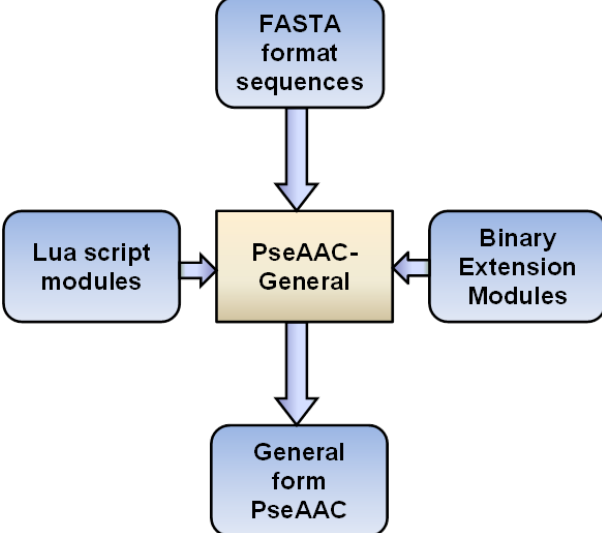
Figure 1. The data flow of pseudo-amino acid composition (PseAAC)-General. The input data is FASTA format sequences. The output data is general form PseAAC. The mode of the general form PseAAC is chosen by the users. For the modes, which are implemented by Binary Extension Modules or Lua script modules, the corresponding modules should be loaded as